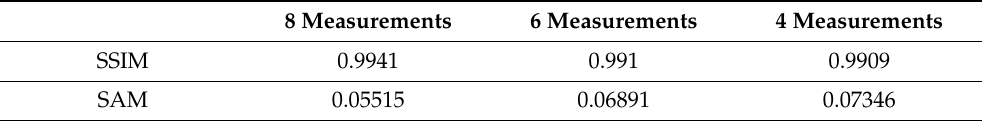
Figure 9. Figure shows 6 spectra reconstruction from the validation/test set. Each spectrum is reconstructed from 3 different SpLMs (yielding 8 measurements, 6 measurements, and 4 measurements). The spectra have 102 bands in the range of (430 nm − 850 nm ) . Table 2. The mean SSIM and mean SAM over the validation/test set of Pavia center for 3 configurations (8 measurements, 6 measurements, and 4 measurements).